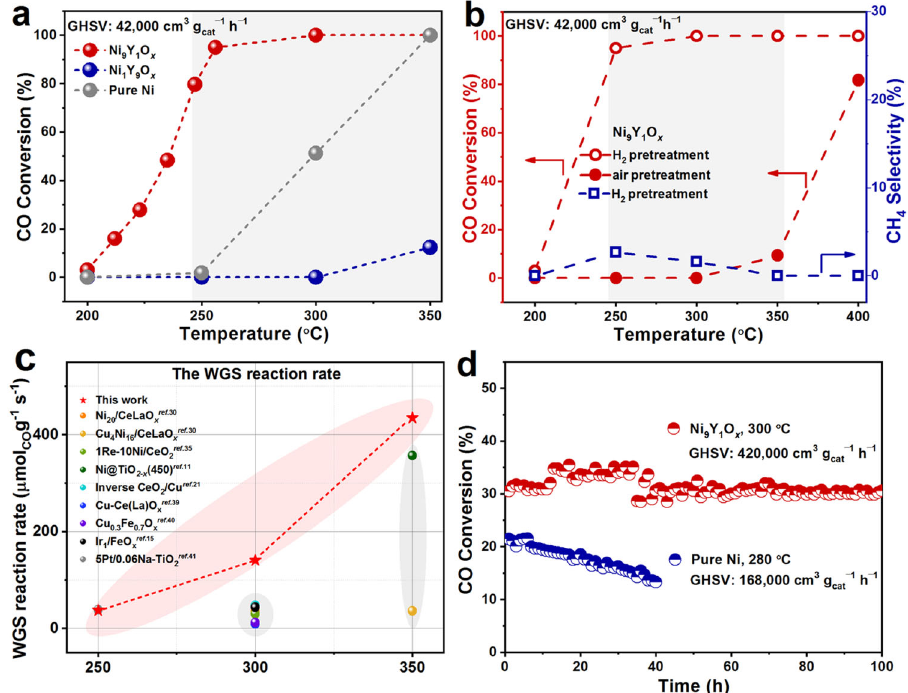
Fig. 1 Catalytic performance test of the Ni a Y b O x catalysts. a Temperature-dependent activities of the catalysts (Ni 1 Y 9 O x , Ni 9 Y 1 O x , pure Ni catalyst, the reaction gas content was 2%CO, 10%H 2 O, and the rest was N 2 ); b temperature-dependent activity and selectivity of Ni 9 Y 1 O x under different pretreatment conditions; c comparison of reaction rates with other Ni-based catalysts; d the long-term stability at a high GHSV (Ni 9 Y 1 O x : 300 °C, GHSV = 420,000 cm 3 g cat − 1 h − 1 ; pure Ni catalyst: 280 °C, GHSV = 168,000 cm 3 g cat − 1 h − 1